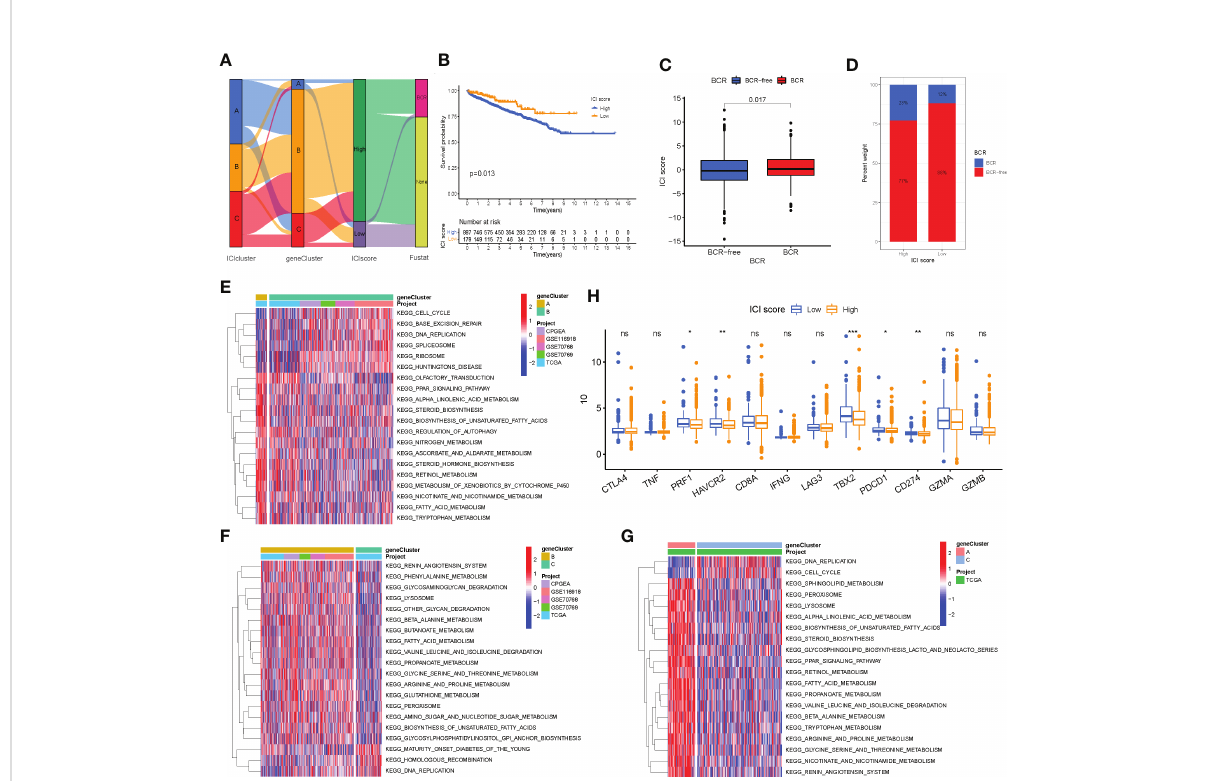
FIGURE 5 Immune cell in fi ltration (ICI) score pattern was constructed. (A) Sankey diagram shows the correlation between gene cluster, ICI score, and biochemical recurrence (BCR) status of prostate cancer patients. (B) The Kaplan – Meier curve was used to predict the prognosis of the ICI score (log-rank test, P = 0.013). (C, D) Higher ICI score in BCR patients than those who are BCR-free (log-rank test, P = 0.017). (E – G) Pathways enriched by three ICI clusters using Kyoto Encyclopedia of Genes and Genomes pathway enrichment analysis and identi fi ed by the “ GSVA ” R